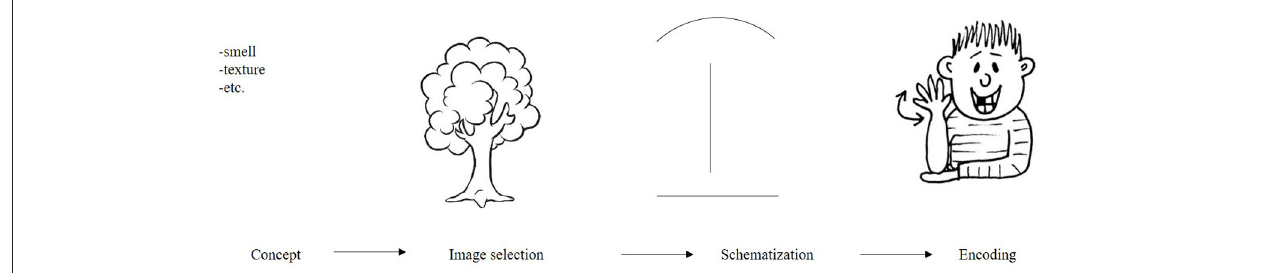
FIGURE 2 | Analog-building process for American Sign Language (ASL) for the object tree as proposed by Taub (2001a).